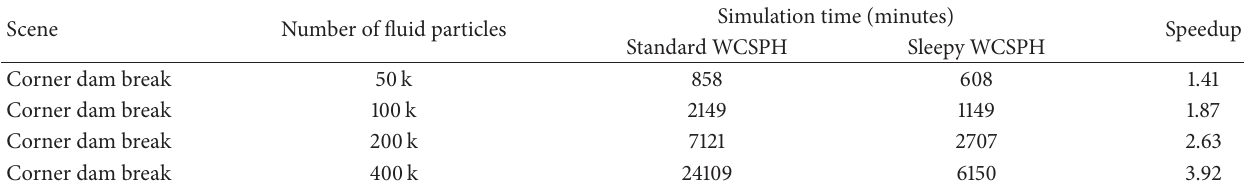
Table 2: Speedup comparison of four different particle counts for Figure